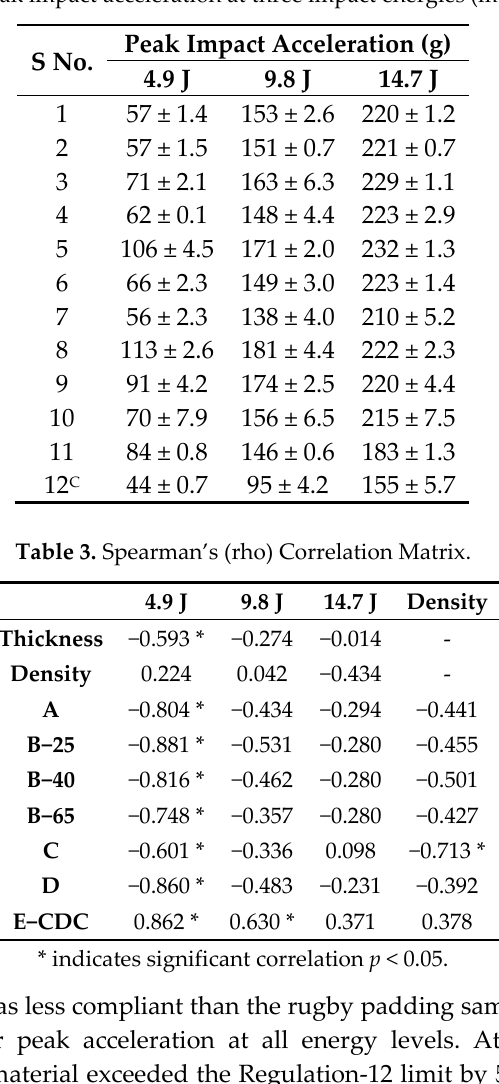
Table 2. Peak impact acceleration at three impact energies (mean ± SD).